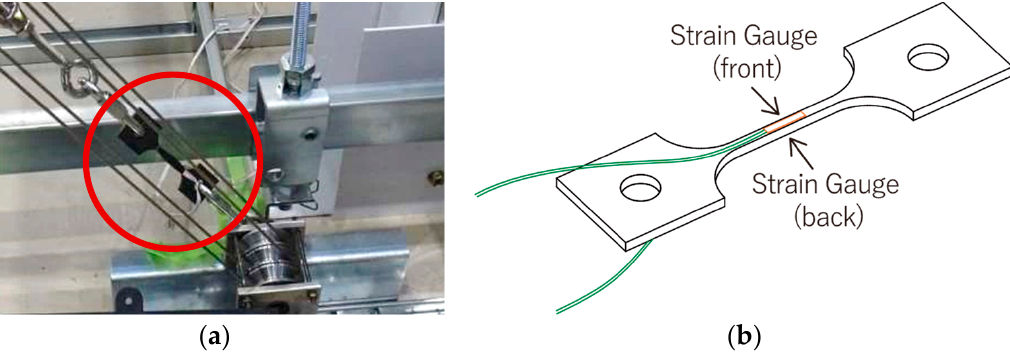
Figure 4. ( a ) Installation of the tension measuring plate at the end of the wire in the specimen; ( b ) details of the tension measuring plate.